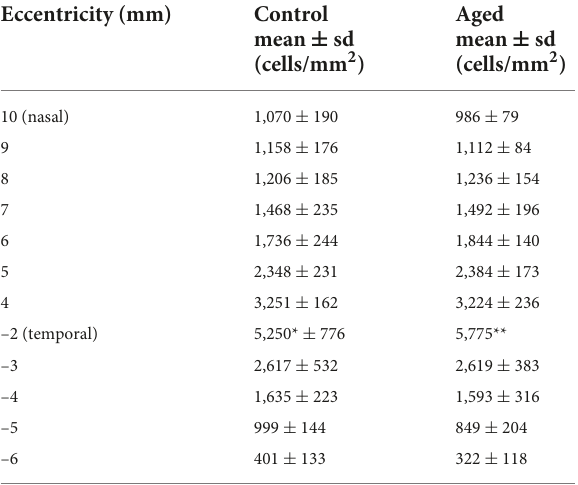
TABLE 3 Ganglion cell density in control and aged